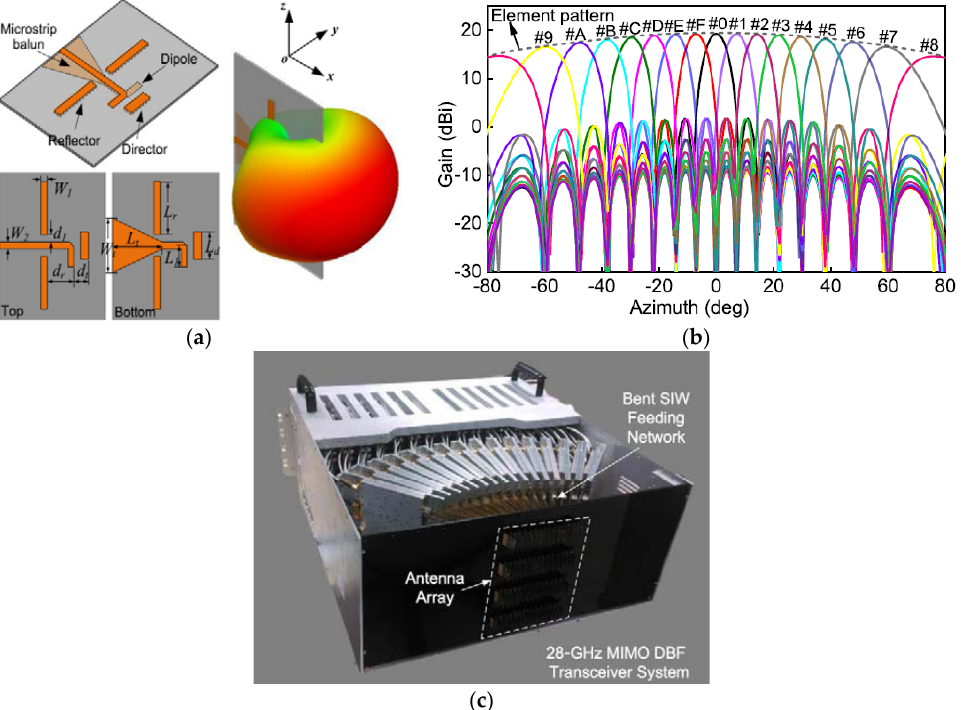
Figure 18. ( a ) Design overview of proposed Yagi-Uda antenna element with its 3D far-field radiation pattern. ( b ) Radiation patterns of 16-element DBF-based phased array in azimuth plane. ( c ) Photograph